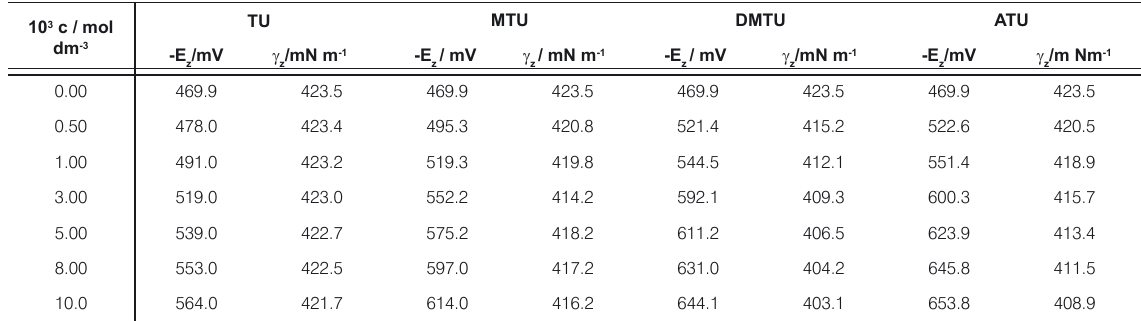
/ mV vs . Ag / AgCl electrode and surface tension γ z